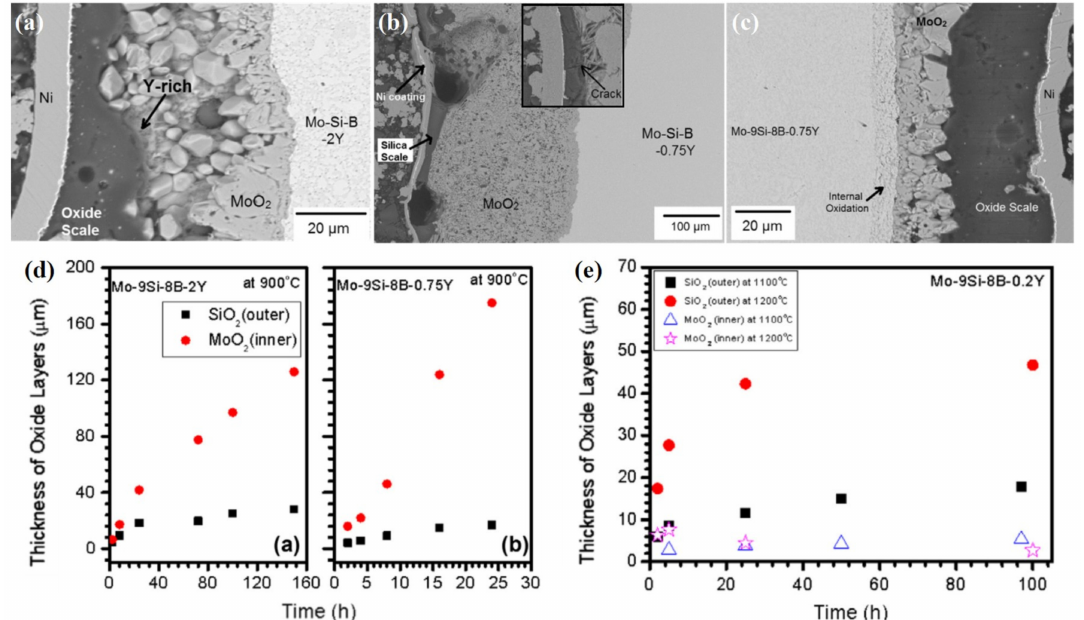
Figure 9. Cross-sectional BSE images of 2 at.% and 0.75 at.% Y-doped samples oxidized at differernt conditions: ( a , b ) 900 ◦ C for 24 h, ( c ) 1100 ◦ C for 72 h; ( d , e ) Changes of MoO 2 laye and SiO 2 layer thickness in Y-doped samples oxidized at different temperatures. Reproduced with permission [122]. Copyright 2014 Elsevier.